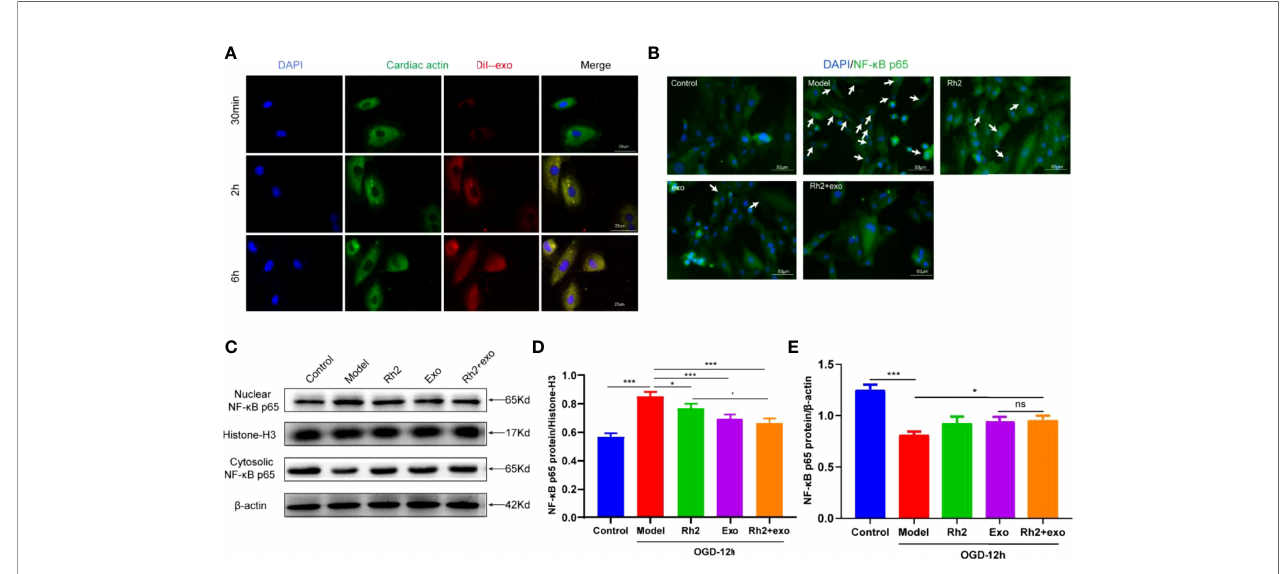
FIGURE 4 | Ginsenoside Rh2 promoted exosome inhibition of NF- k B nuclear translocation. (A) Enrichment of DiI-labeled exosomes in cardiomyocytes at different time points (30 min/2 h/6 h). (B) The protein expression levels of the NF- k B p65 (green color) in cardiomyocyte nuclear by immuno fl uorescence, and the slides were counterstained with DAPI (blue). Representative images of western blotting (C) and quantitative data (D, E) of the protein levels of NF- k B p65 in the nuclear and cytosolic. One-way ANOVA test was used for statistical analyses. Bars represent means ± SD; *P < 0.05, ***P < 0.001 . ns, no signi fi